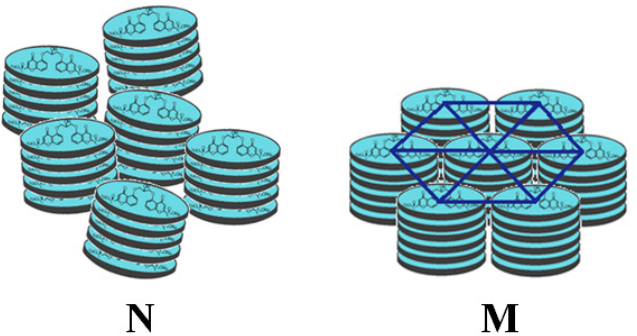
Figure 1. Scheme of the N ( left ) and M phases ( right ) for a chromonic liquid crystal.